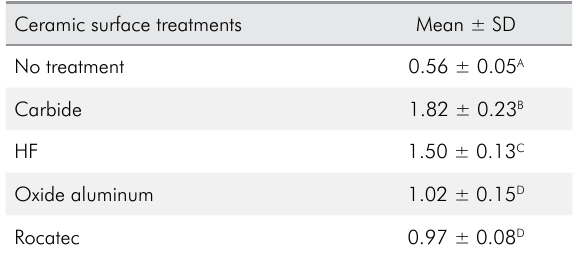
Table 3. Mean values (in °) and standard deviations (SD) of contact angle data from Tukey’s test.